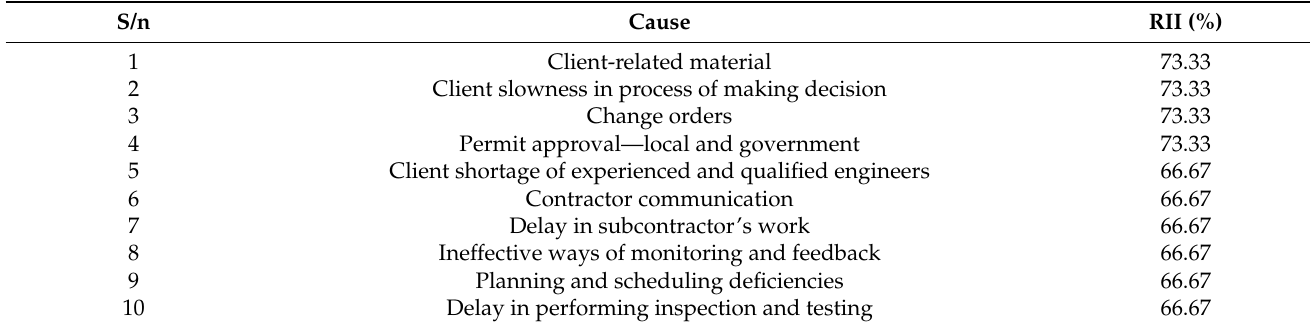
Table 8. Top ten causes from consultant point of